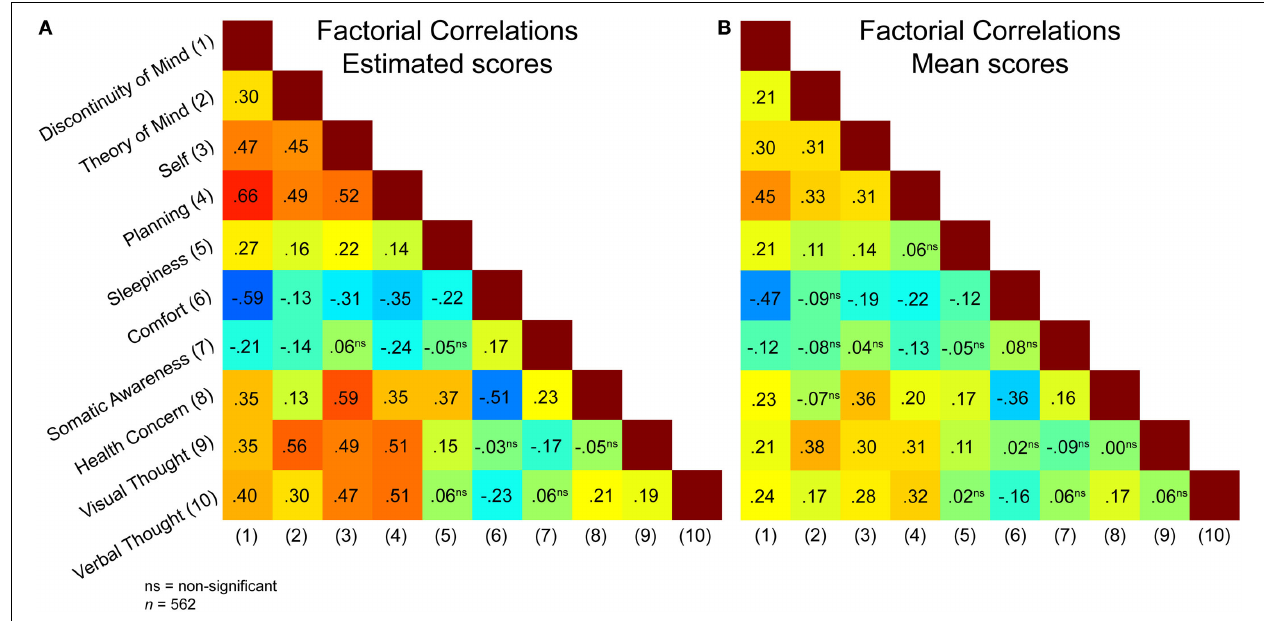
FIGURE 2 | Relationships among ARSQ dimensions for the 10-factor model. Factorial correlations among factors for the CFA model (A) are similar in magnitude and direction to the correlations among